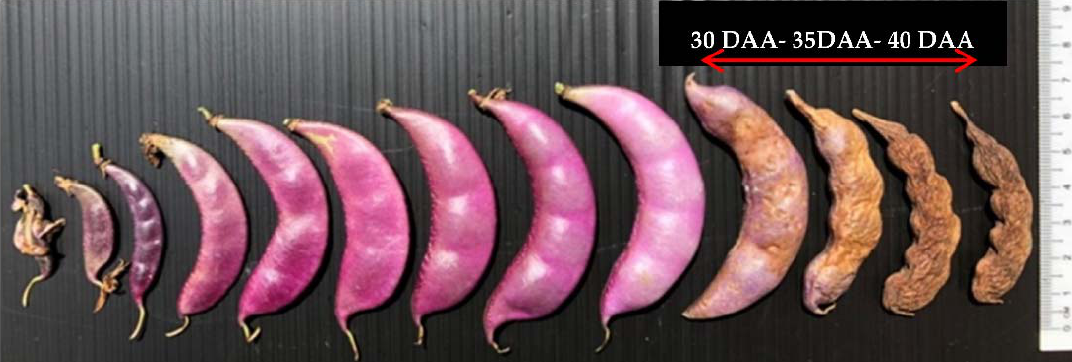
Figure 3. Pod formation and maturation of Lablab purpureus L., and changes in pod colour occur from purple to light brown starting at 30–40 DAA.